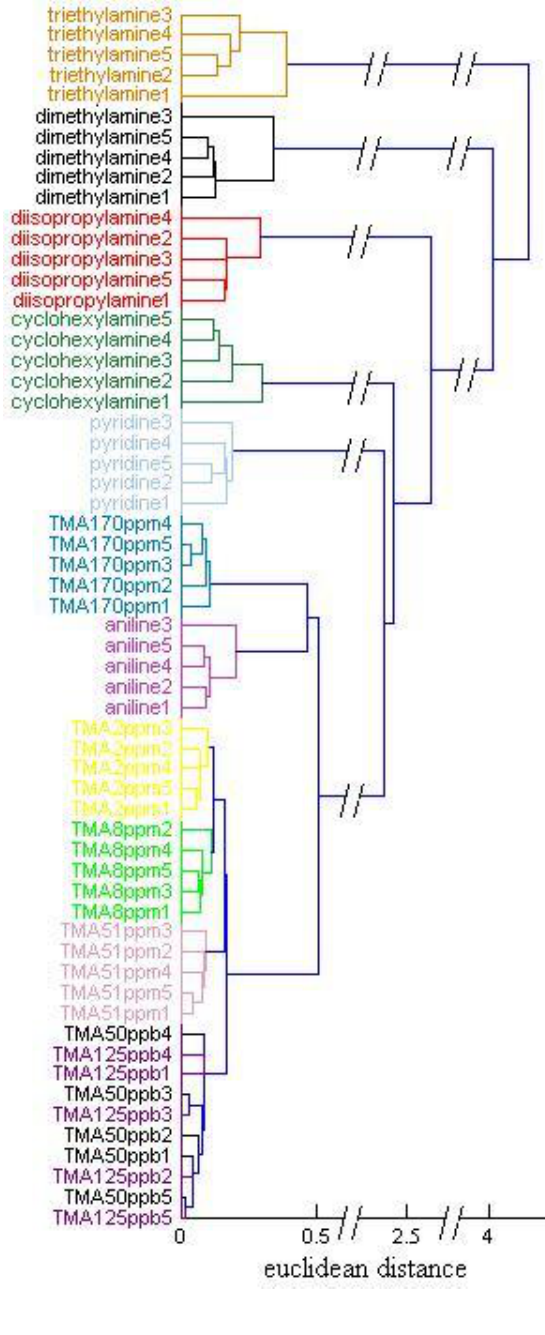
Figure 8. HCA dendrogram for 12 amine analytes using euclidean distance and single linkage with the Matlab statistic tool